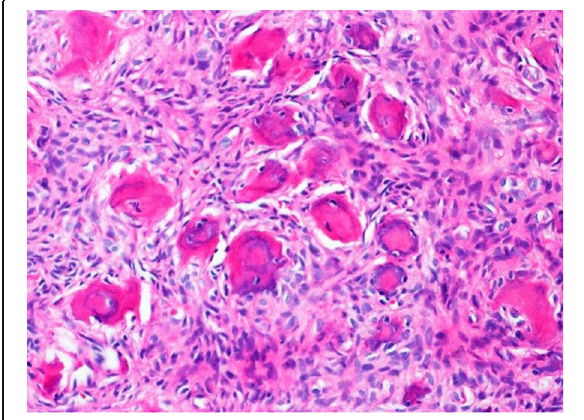
Fig. 6 Chromotrope aniline blue staining highlights the fibrous